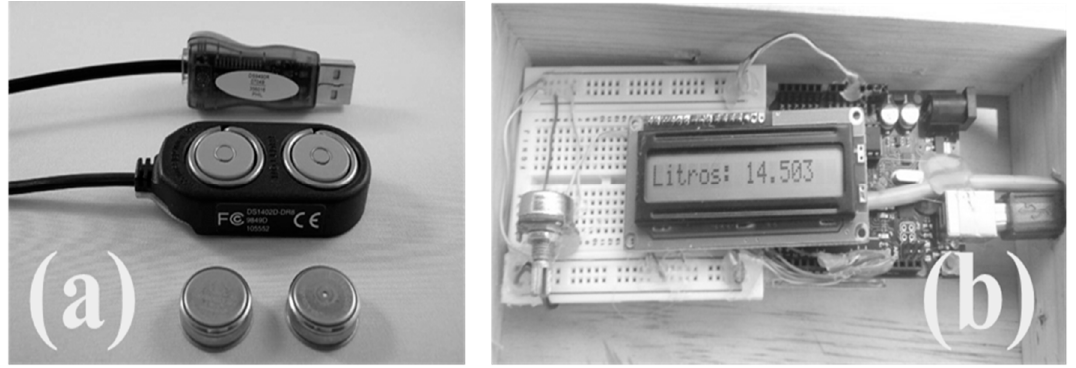
Figure 2. ( a ) Stove use monitor (SUM) sensors and data recorder; ( b ) YF-S201 flowmeter with data